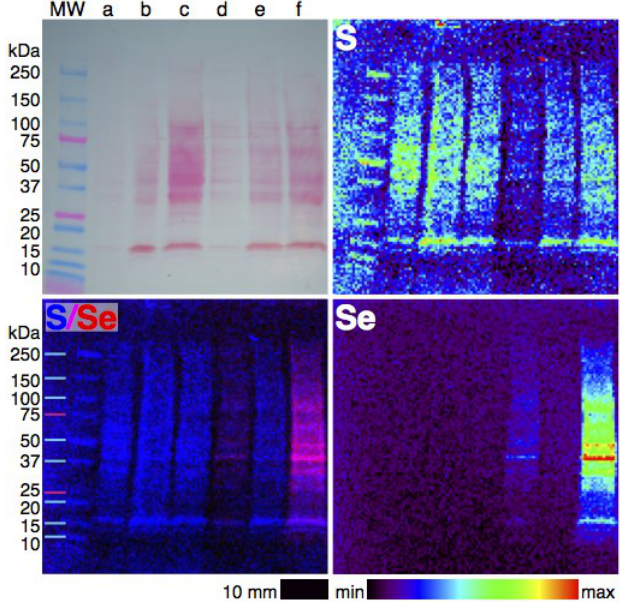
Figure 5. Photograph (top right) and XFM elemental distribution maps of S, Se and an overlay of S and Se in an SDS-PAGE blot of the lysates of cells treated with selenium compounds for 24 h. The wells contain lysates of cells treated with ( a ) 5 µM selenite, ( b ) PBS alone (as vehicle control), ( c ) 50 µM MeSeCys, ( d ) 50 µM SeMet, ( e ) 1 µM selenite or ( f ) 100 µM SeMet. The color scheme indicates the relative concentration within each elemental